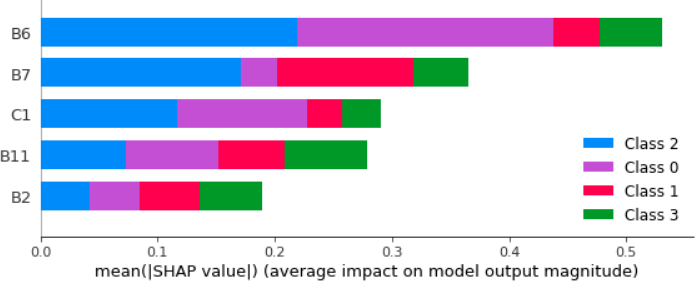
Figure 7. The five most significant features as input in the SVM model for the correct classification of sugarcane varieties. Respectively, the Sentinel-2 bands B6 (band 6—Vegetation Red-Edge), B7 (band 7—Vegetation Red-Edge), combination C1 (band 8, band 6, and band 4), B11 (band 11—SWIR), and B2 (band